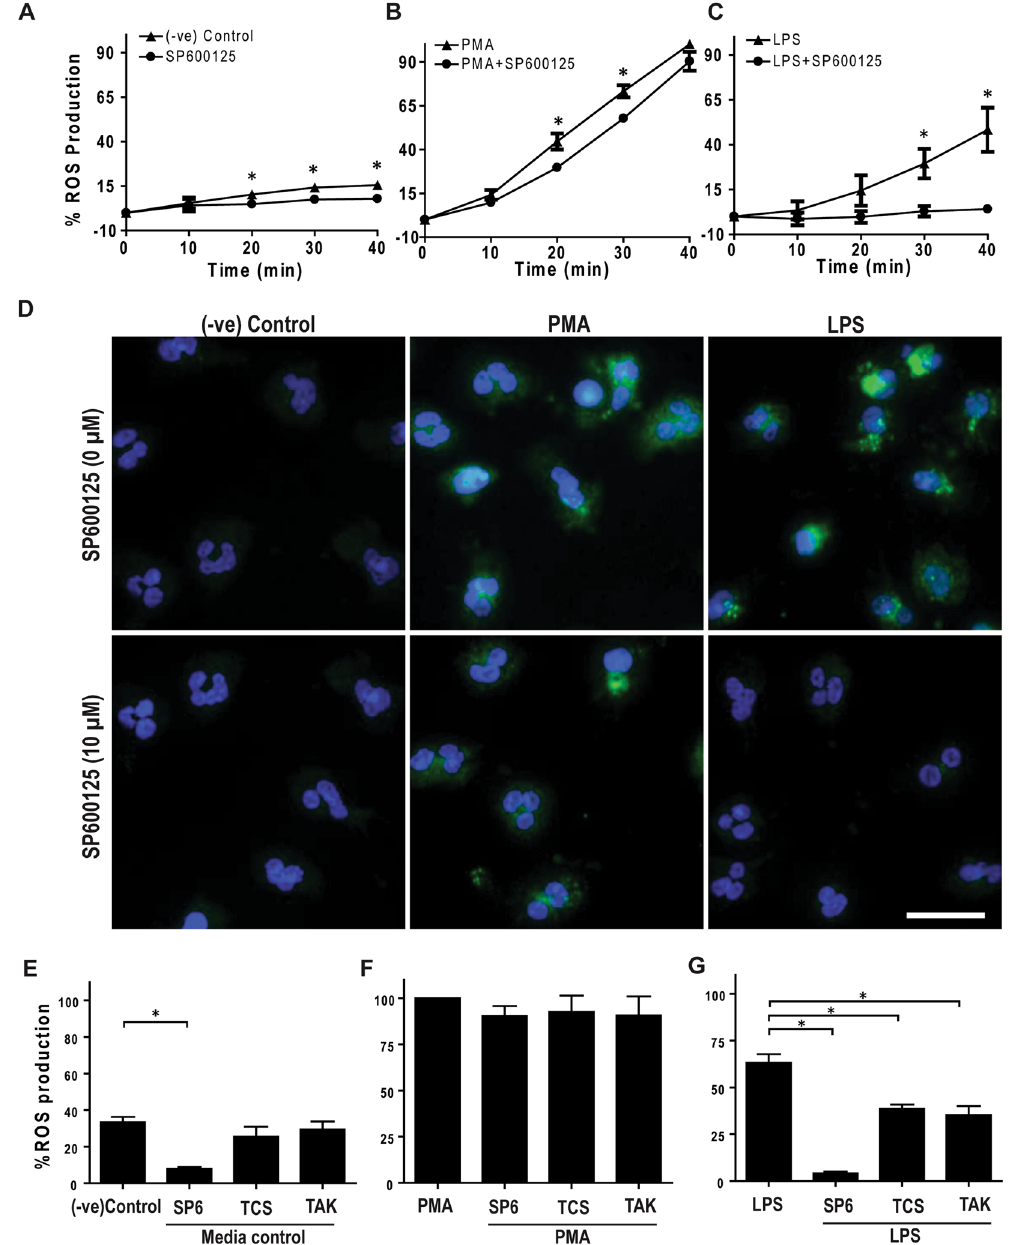
Figure 2. LPS-mediated ROS production in human neutrophils depends on TLR4 signaling and JNK activation . Human neutrophils were treated with cytosolic ROS indicator dye DHR123 and activated with PMA (25 nM), LPS (25 μ g/ml) or only media (-ve control) in the presence or absence of JNK inhibitor SP600125 or TCSJNK6o (TCS), or TLR4-TIRAP/TRAM inhibitor TAK242 (TAK). ( A–C; E–G ) R123 based ROS generation kinetics by plate reader assays show that both PMA and LPS induce ROS generation, over 40 min of post activation. JNK inhibition with both SP600125 and TCSJNK6o drastically reduces the generation of ROS in LPS treated Neutrophils, while inhibitors do not suppress ROS generation in neutrophils activated with PMA. The ROS values were calculated by considering the PMA-mediated ROS production as 100% at 40-minute time point (n = 3, * p-value < 0.05; Two-way ANOVA with Bonferroni’s multiple comparison post test). ( D ) Confirmation of generation and inhibition of ROS by confocal imaging. R123 (green) and DNA (blue). Confocal images confirm the inhibition of ROS in LPS activated neutrophils but not in neutrophils activated with PMA, at 60-minute time point (n = 3; scale bar 20 μ m). ( E–G ) Measuring R123-based ROS generation kinetics by plate reader assays show that TLR4-TIRAP/TRAM inhibition with TAK242 significantly reduces the generation of ROS in LPS treated Neutrophils. However, the inhibitor does not suppress ROS generation in neutrophils activated with PMA. The ROS values were calculated by considering the PMA-mediated ROS production as 100%, at 40-minute time point (n = 3, * p-value < 0.05; One-way ANOVA with Tukey’s post test compared to negative control). See Supplementary Fig. S2 for relative changes in ROS production. Error bars in all the panels represent